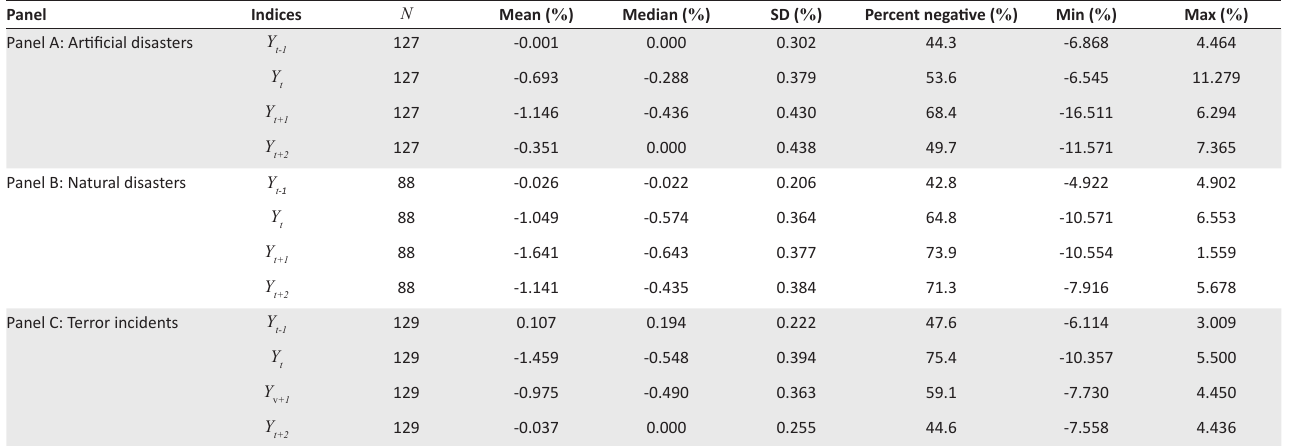
TABLE 2: Influence of type of event on the capital market during the 4 days around the event. Panel